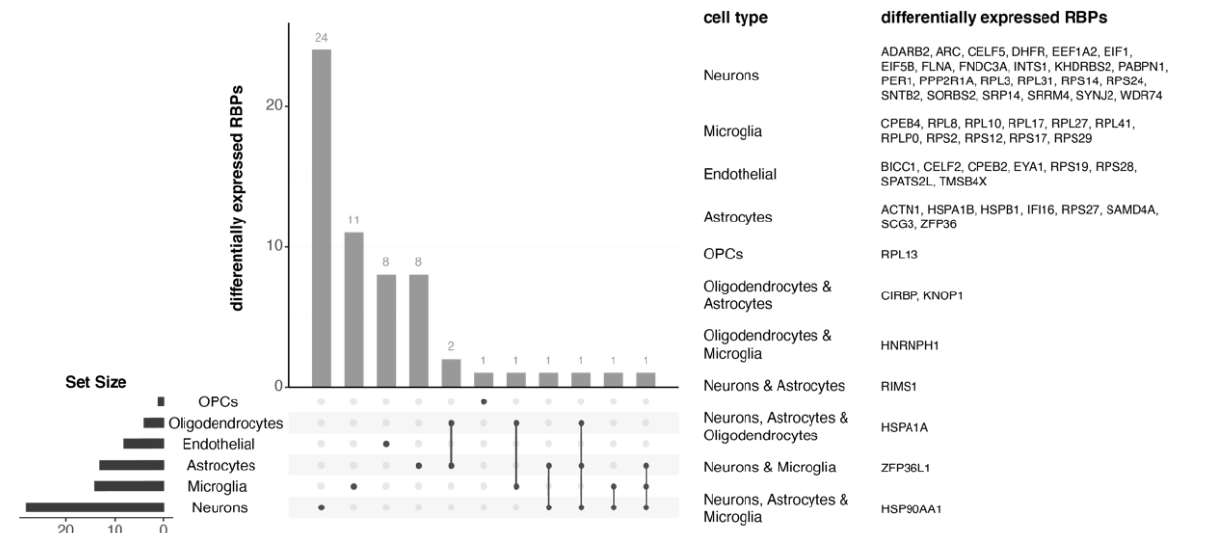
Figure 2. RBPs differentially expressed in individual cell populations in AD. 59 RBPs are differentially expressed at the mRNA level in snRNA-seq data. The majority of them are differentially expressed in a single cell type. Most differentially expressed RBPs are found in neurons (24 RBPs), although we also found a significant number of them in microglia (11 RBPs), astrocytes (8 RBPs), and endothelial cells (8 RBPs).